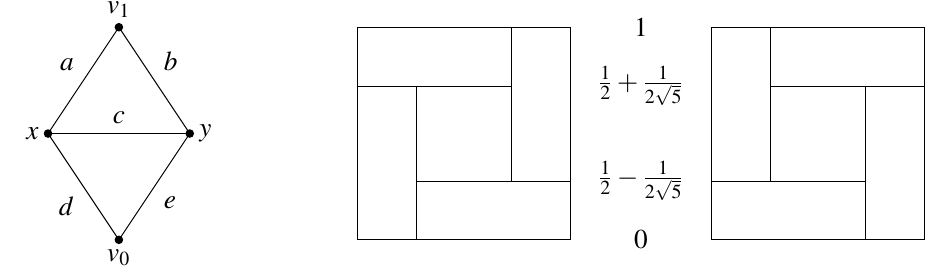
Σ = 2. With u ( v 0 ) = 0 , u ( v 1 ) = 1 and all energies equal, the underlying number | |